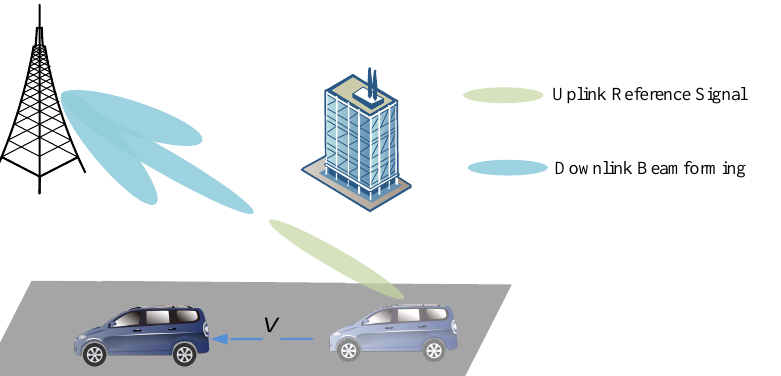
Figure 1. In TDD mobile communication systems, the beamforming performance of high-speed mobile terminal worsens. The user sends a SRS, and the base station runs channel estimation algorithms and performs beamforming. However, due to the user’s movement, the terminal can only obtain sidelobe gain in the downlink slots.